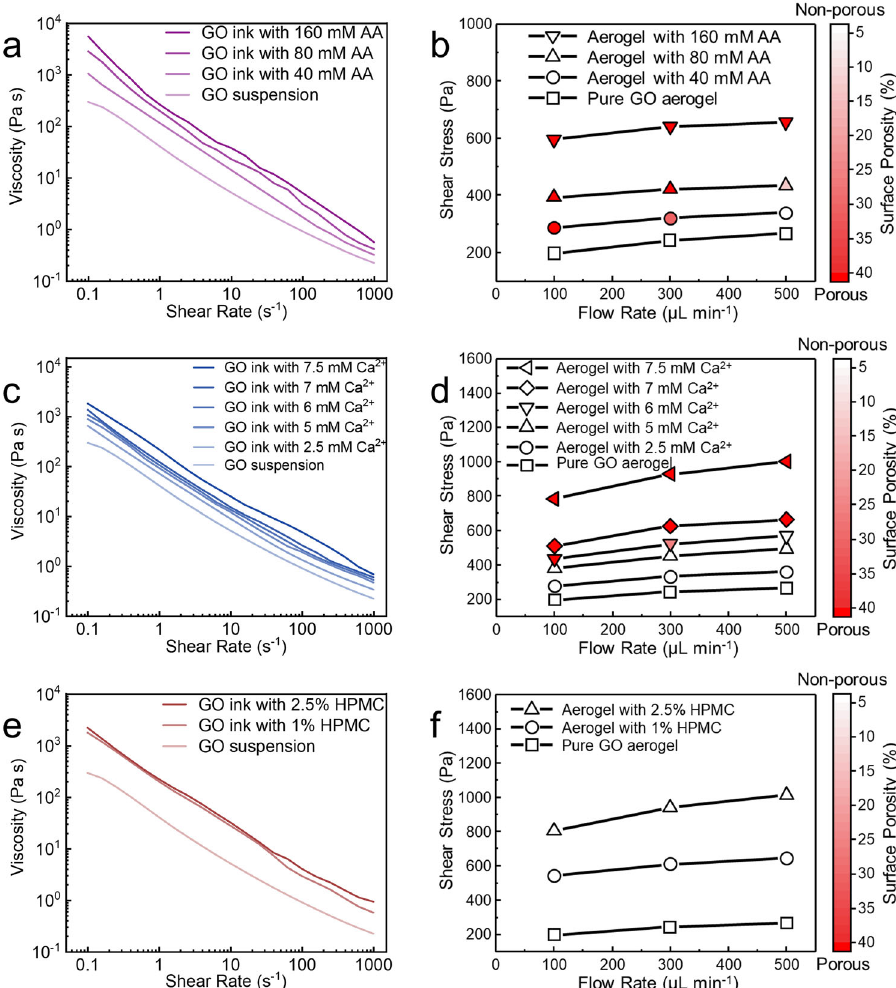
Fig. 3 The in fl uence of crosslinking degree on surface porosity. a Apparent viscosity as a function of shear rate for GO ink modi fi ed by AA. b Surface shear stress and surface porosity of aerogels with different concentrations of AA, printed by 0.210 mm nozzle. c Apparent viscosity as a function of shear rate for GO ink crosslinked by Ca 2 + . d Surface shear stress and surface porosity of aerogels with different concentrations of Ca 2 + , printed with 0.210 mm nozzle. e Apparent viscosity as a function of shear rate for GO ink mixed with HPMC. f Surface shear stress and surface porosity of aerogels with different ratios of HPMC, printed with 0.413 mm nozzle. Surface shear stress is obtained by CFD simulation (see